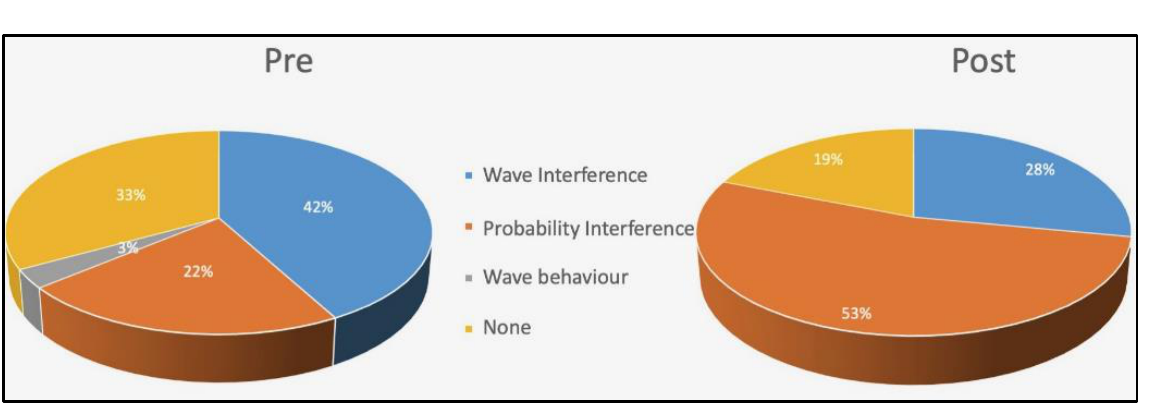
Figure 7. Students’ reasoning for the explanation of single photon interference.